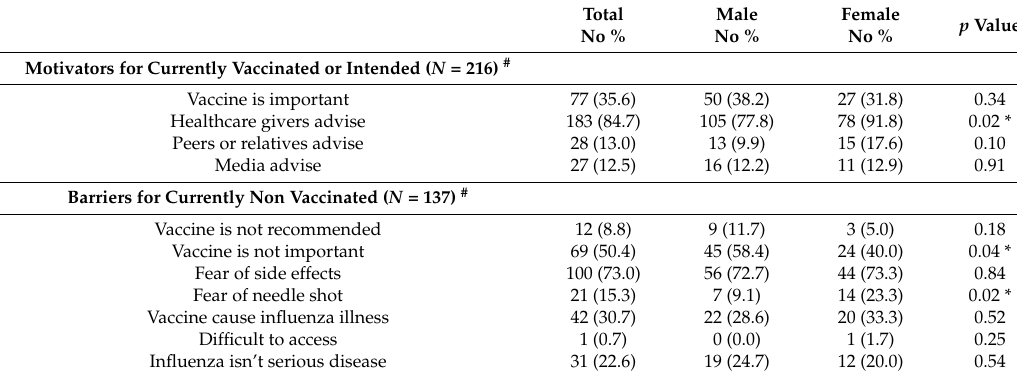
Table 2. Motivators and barriers for seasonal influenza vaccination in the study T2DM patients by gender.